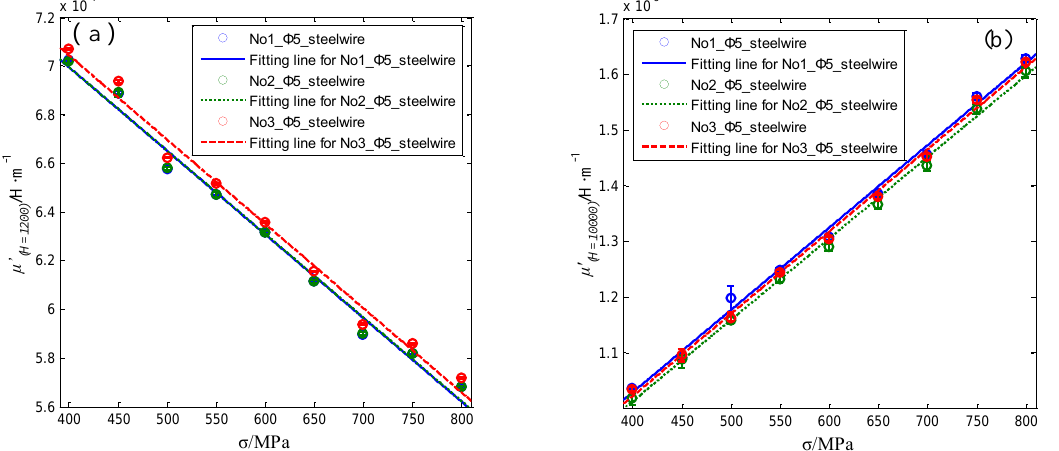
Figure 16. The relationship of axial stress in the three Φ5 steel wires with differential permeability at working points H = 1200 A/m ( a ) and H = 10,000 A/m ( b ).